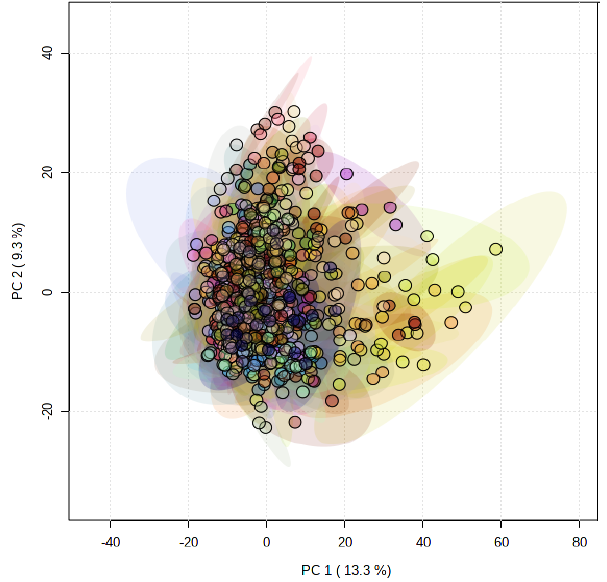
Figure 1. Principal component analysis (PCA) of metabolite profiles of 197 pearl millet accessions. Each ellipsis describes the variation within four replicates of a single accession.